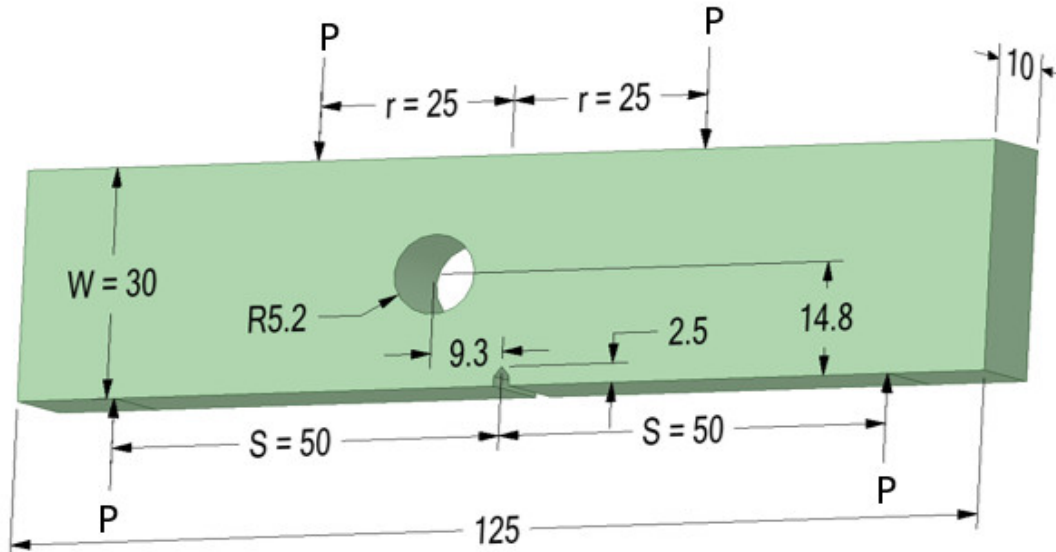
Figure 1. Geometry of the four-point bending beam (dimensions in mm).